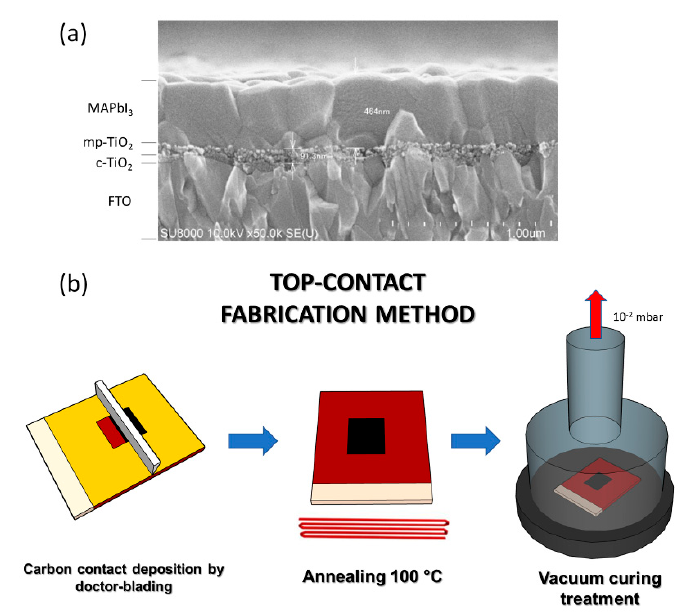
Figure 1. Top-contact fabrication method: ( a ) Cross-sectional scanning electron microscopy (SEM) image showing the MAPbI 3 layer with large grains and a flat interface with the electron-transporting layer (ETL); ( b ) Schematic of top-contact fabrication on a perovskite solar cell (PSC) and successive vacuum curing treatment.